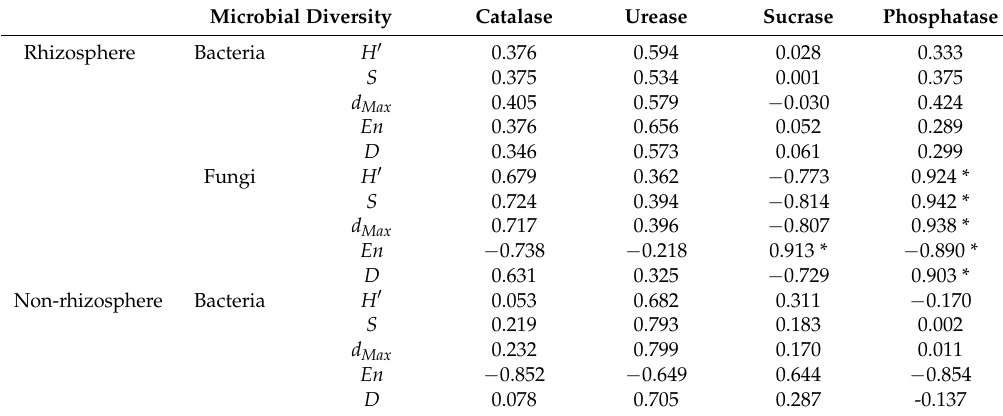
Table 2. The Pearson correlations among soil enzyme activities and diversity indices of soil microbial community.